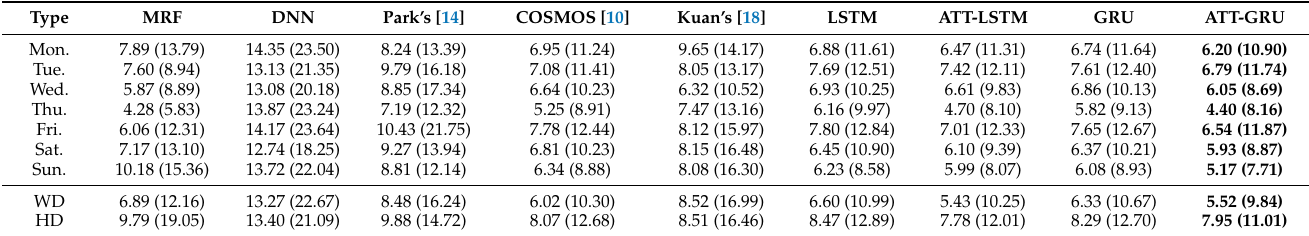
Table 12. MAPE (CVRMSE) comparison by date types for Building 3. WD and HD denote weekdays and holidays, respectively.